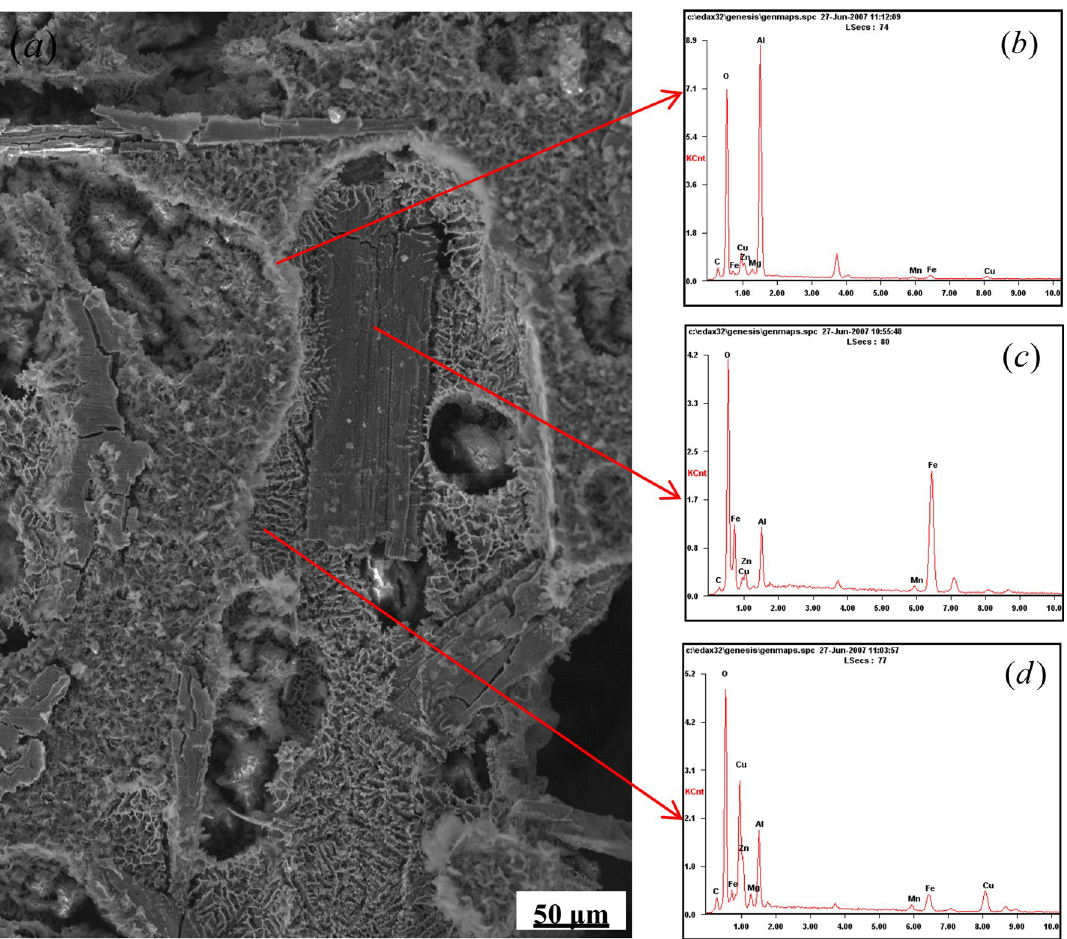
Figure 7. the quenched microstructure and EDS of Al–Fe–Cu alloy reheated at 630 °C for 40 min, deep etched. ( a ) Microstructure; ( b ) α-Al grain; ( c ) Fe-rich phase; ( d ) Cu-rich 3 or 5 specimens and quenched them in cold water after holding the scheduled time until the experiment was completed at the temperature. The solid–liquid region of this alloy was measured by differential thermal analysis and was 505.2–649.9 °C. The DSC tests were carried out using a TA Q100 differential scanning calorimeter. DSC samples were pressed into smooth sheets with a diameter of 5 mm and a thickness of 1 mm, and put into a special copper crucible, and the samples were heated from room temperature to 900 °C at a rate of 10 °C/min and cooled to room tem- perature at the same rate. Meanwhile, a protective gas, pure nitrogen, was injected at a rate of 60 ml/min. Before the experiment, high-purity zinc (419.4 °C) and high-purity aluminum (660.37 °C) were used for melting point correction at the same rate. Figure 11 shows a plot of the isothermal holding temperatures and corresponding liquid volume fractions determined by differential scanning calorimetry (DSC) and the graphic method. Kim et al. 30 believed that the release of the latent heat of solidification during solidifying is approximately proportional to the solidification amount of solid phase. Therefore, the area ratio of DSC exothermic curve can be used to determine the liquid–solid ratio of the alloy at different temperatures. The area integral of small step length was adopted to calculate the area ratio. The DSC heating rate was higher than the actual heating rate of specimens, which should rearward shift the endothermic peak in the curve, resulting in the phase transformations delaying and peak temperature increasing. The liquid fraction, average grain size, and shape factor ( SF ) of the solid phase measured by means of an OLYMPUS BX60M optical microscope with ISA-4 image analyzer system. The equivalent (average) diameter and SF of solid grains are calculated in each state by applying the Eqs. (2) and (3) 31 .